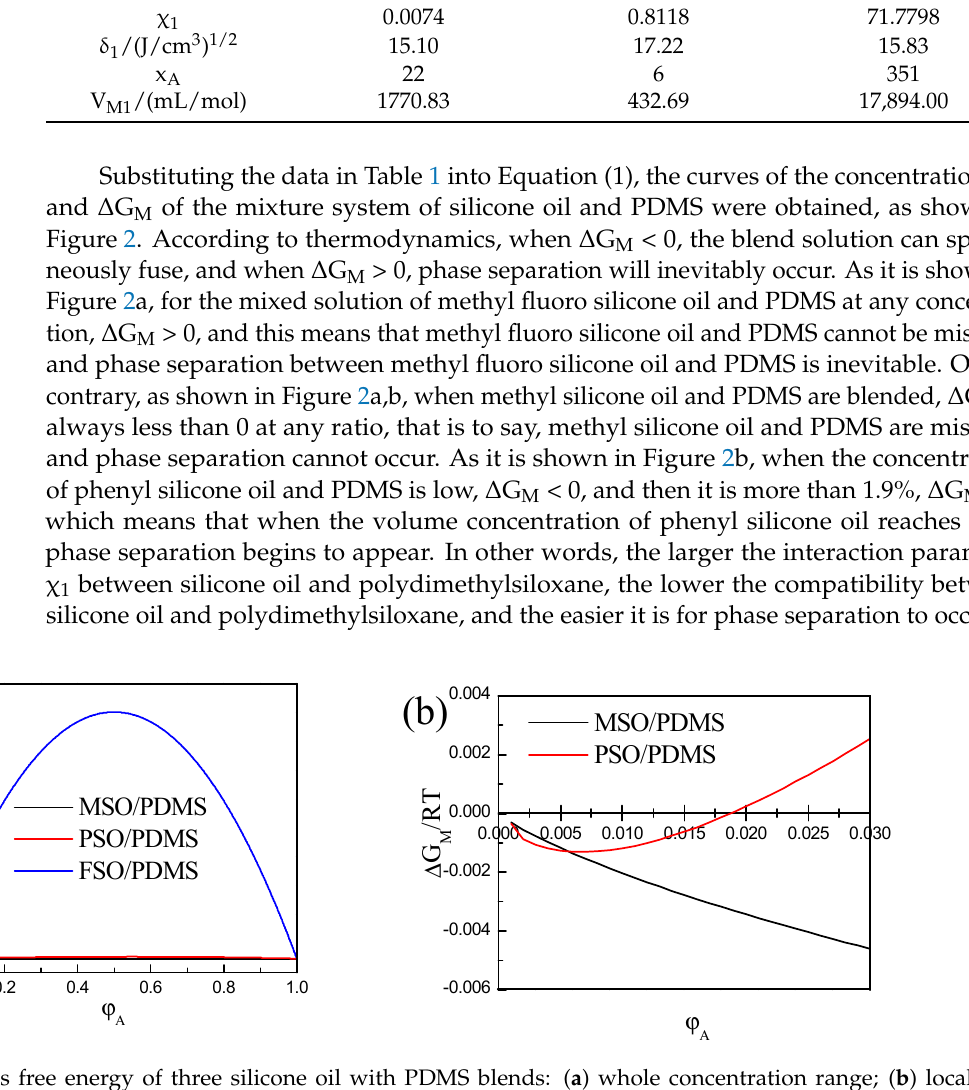
Figure 2. Mixed Gibbs free energy of three silicone oil with PDMS blends: ( a ) whole concentration range; ( b ) local amplification for low concentrations.